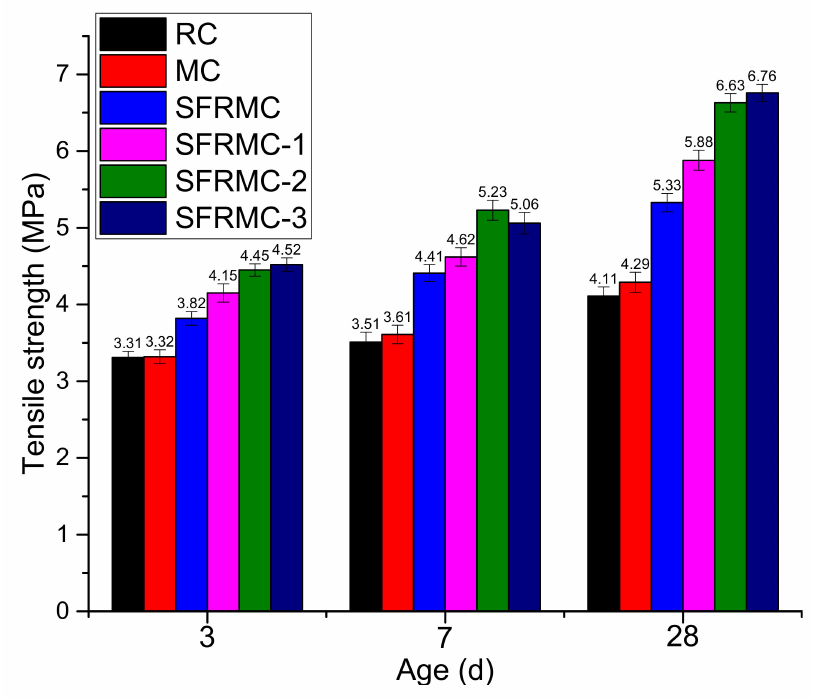
Figure 7. Split tensile strength of